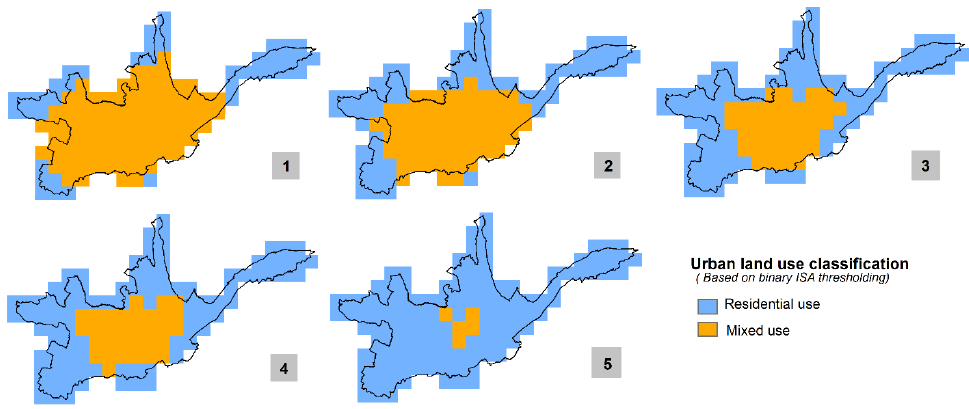
Figure 6. Binary land use classification of Cuenca City based on ISA thresholds from Table 1. Blue indicates residential and orange mixed use. Table record IDs are indicated in the figure as 1–5.